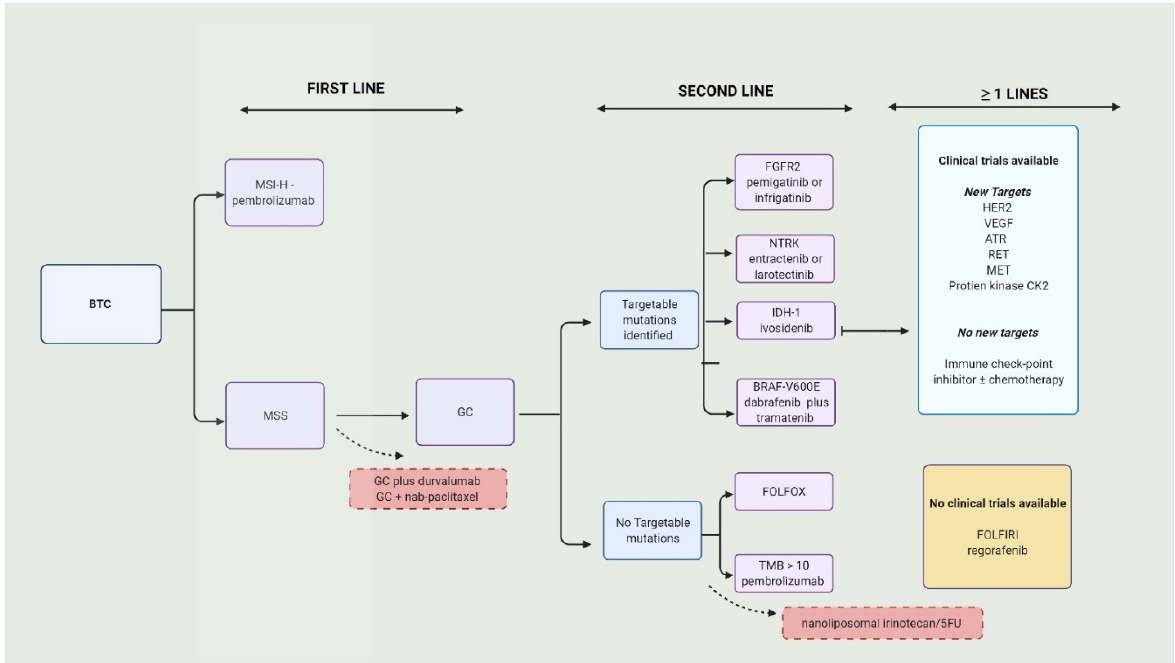
Figure 1. Current approach to biliary tract cancers. BTC—biliary tract cancers; MSI-H—microsatellite instability; MSS—microsatellite stable; GC—gemcitabine/cisplatin; FGFR2—fibroblast growth factor 2; IDH—isocitrate dehydrogenase-1; NTRK—neurotrophic tyrosine receptor kinase; HER2—human epidermal growth factor receptor 2 inhibitors; VEGF—vascular endothelial growth factor; TMB—tumor mutational burden; ATR—ataxia telangiectasia mutated and Rad3-related